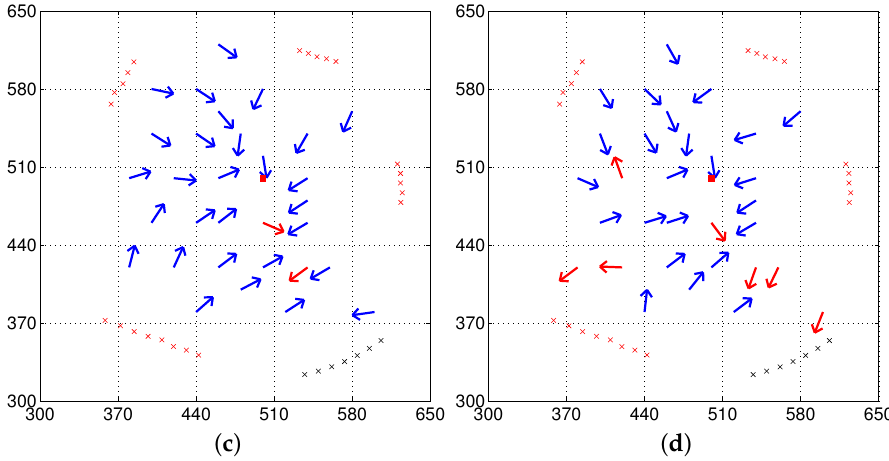
Figure 12. Experiments with missing landmarks or added landmarks (left column: with the reference compass, right column: without the reference compass) ( a , b ) env1 with an object removed at home location and ( c , d ) env1 with an object added at home location; black circles (at the right side) in ( a , b ) indicate landmarks removed only at the home position and black x marks (at the lower right corner) in ( c , d ) indicate landmarks added only at the home position (red x marks represent landmarks observed at any position except the home position and far background areas not shown, although they are